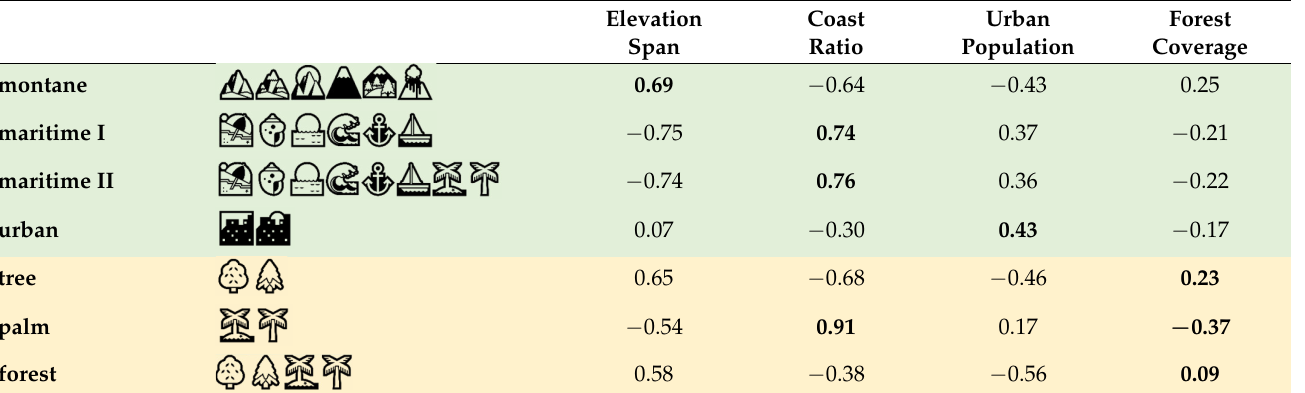
Table 3. Correlation between the typicality of environmental groups of location-specific emojis within each Italian region and the four geographical attributes (bold: respective representative geographical attribute; green: correlation coefficient for representative geographical attribute is positive and the maximum; yellow: correlation coefficient for representative geographical attribute is positive, but not the